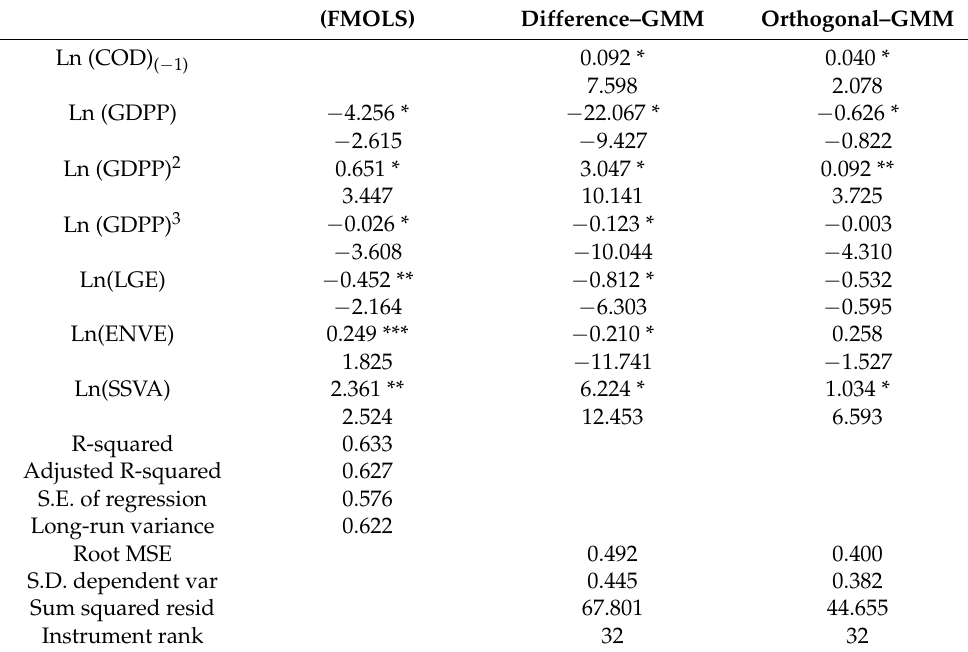
Table 5. Results for the second-stage estimation using the chemical oxygen demand (COD) as the dependent